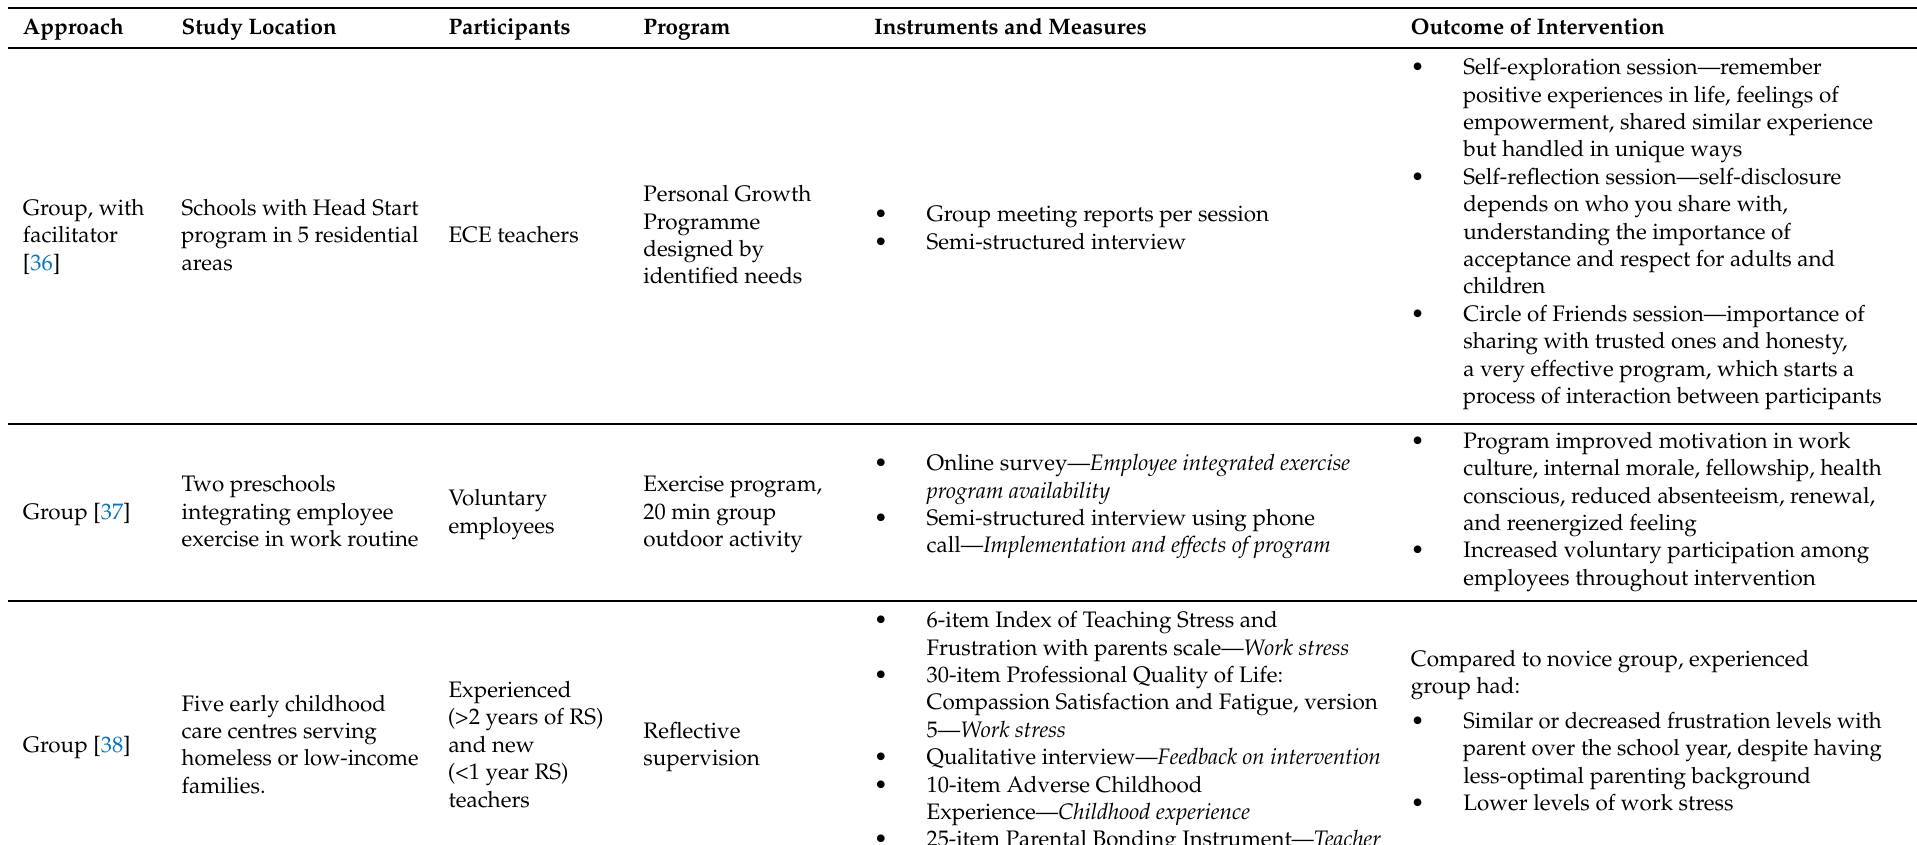
Table 1. Overview of interventions conducted by selected